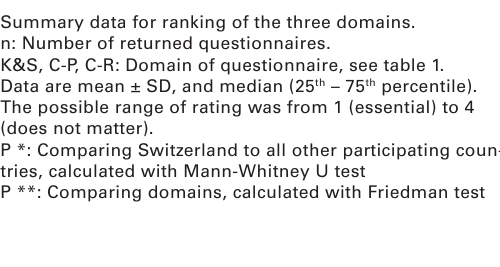
Summary data for ranking of the three domains. n: Number of returned questionnaires. K&S, C-P, C-R: Domain of questionnaire, see table 1. Data are mean ± SD, and median (25 th – 75 th percentile). The possible range of rating was from 1 (essential) to 4 (does not